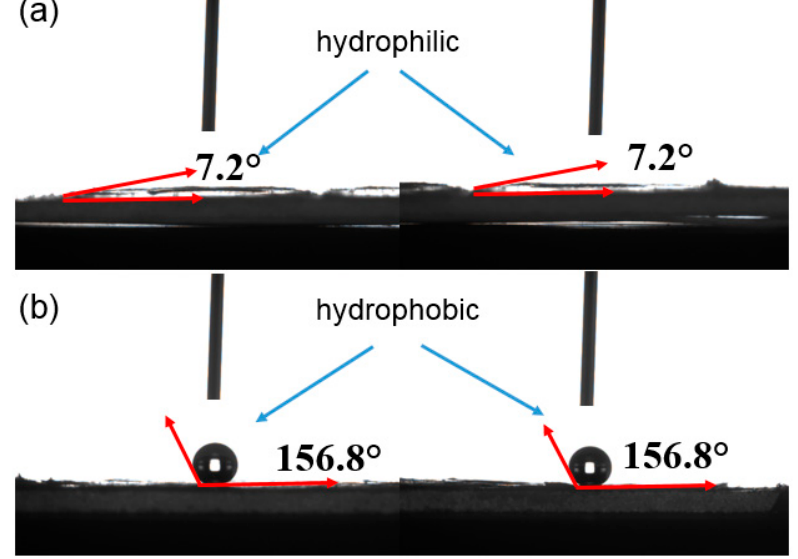
Figure 3. Water contact angles of SiO 2 aerogel ( a ) and M-SiO 2 aerogel ( b ).